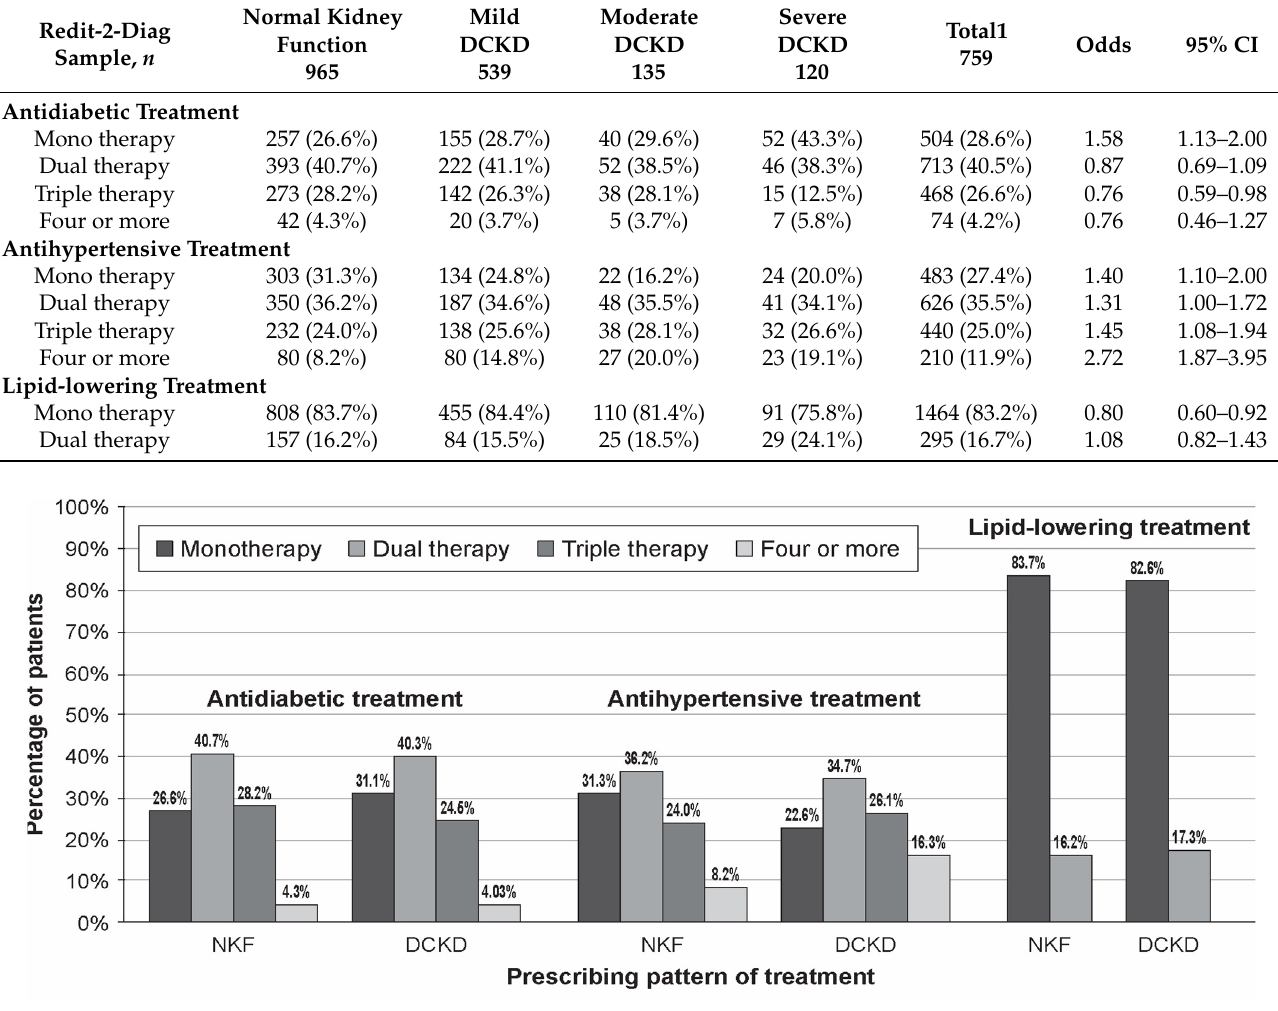
Table 3. Prescribing pattern of antidiabetic and antihypertensive agents in the two-group analysis (normal kidney function vs. DCKD).